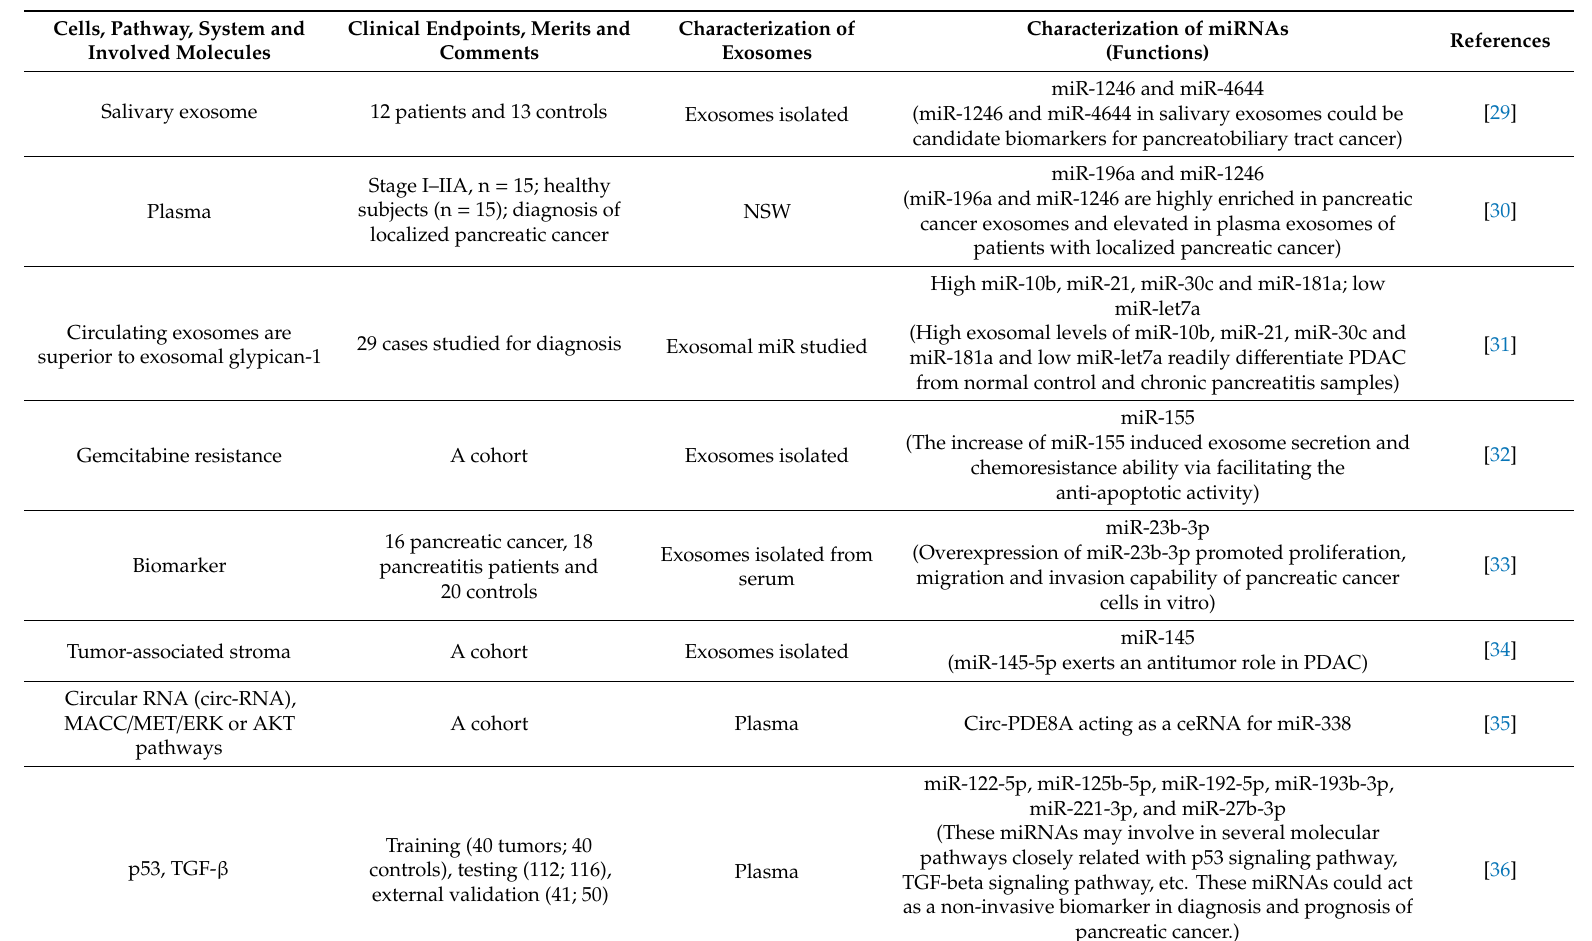
Table 2. Clinical significance of exosomes and miRNAs in pancreatic